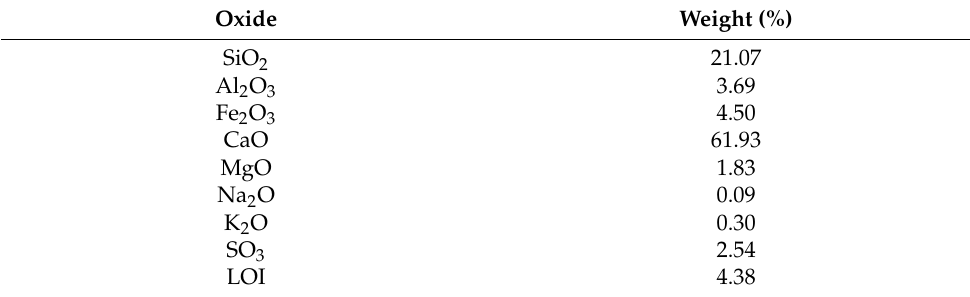
Table 1. Chemical composition of the Portland